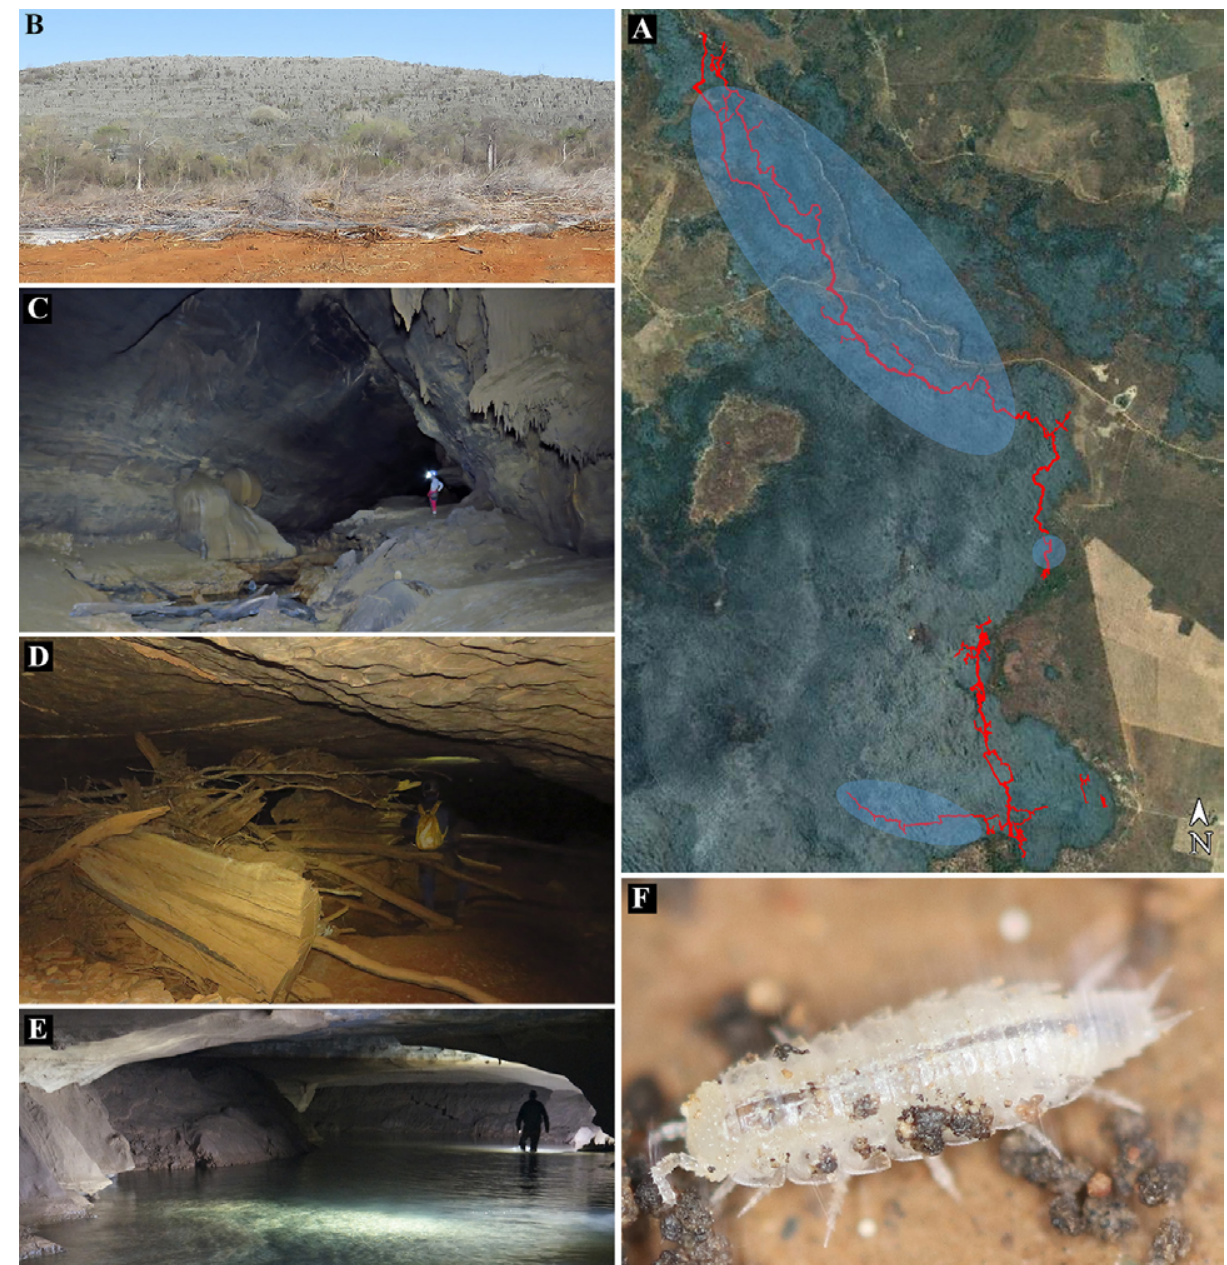
Figure 13. Pectenoniscus carinhanhensis n. sp. A , Águas Claras karst system (extension of caves in red, circles mark species occurrence; B , karst area of Serra do Ramalho; C , main conduit of Águas Claras cave; D , accumulated organic material in the conduit of Águas Claras cave; E , main conduit of Peixes II cave; F , specimen of Pectenoniscus carinhanhensis n. sp., approximately 3